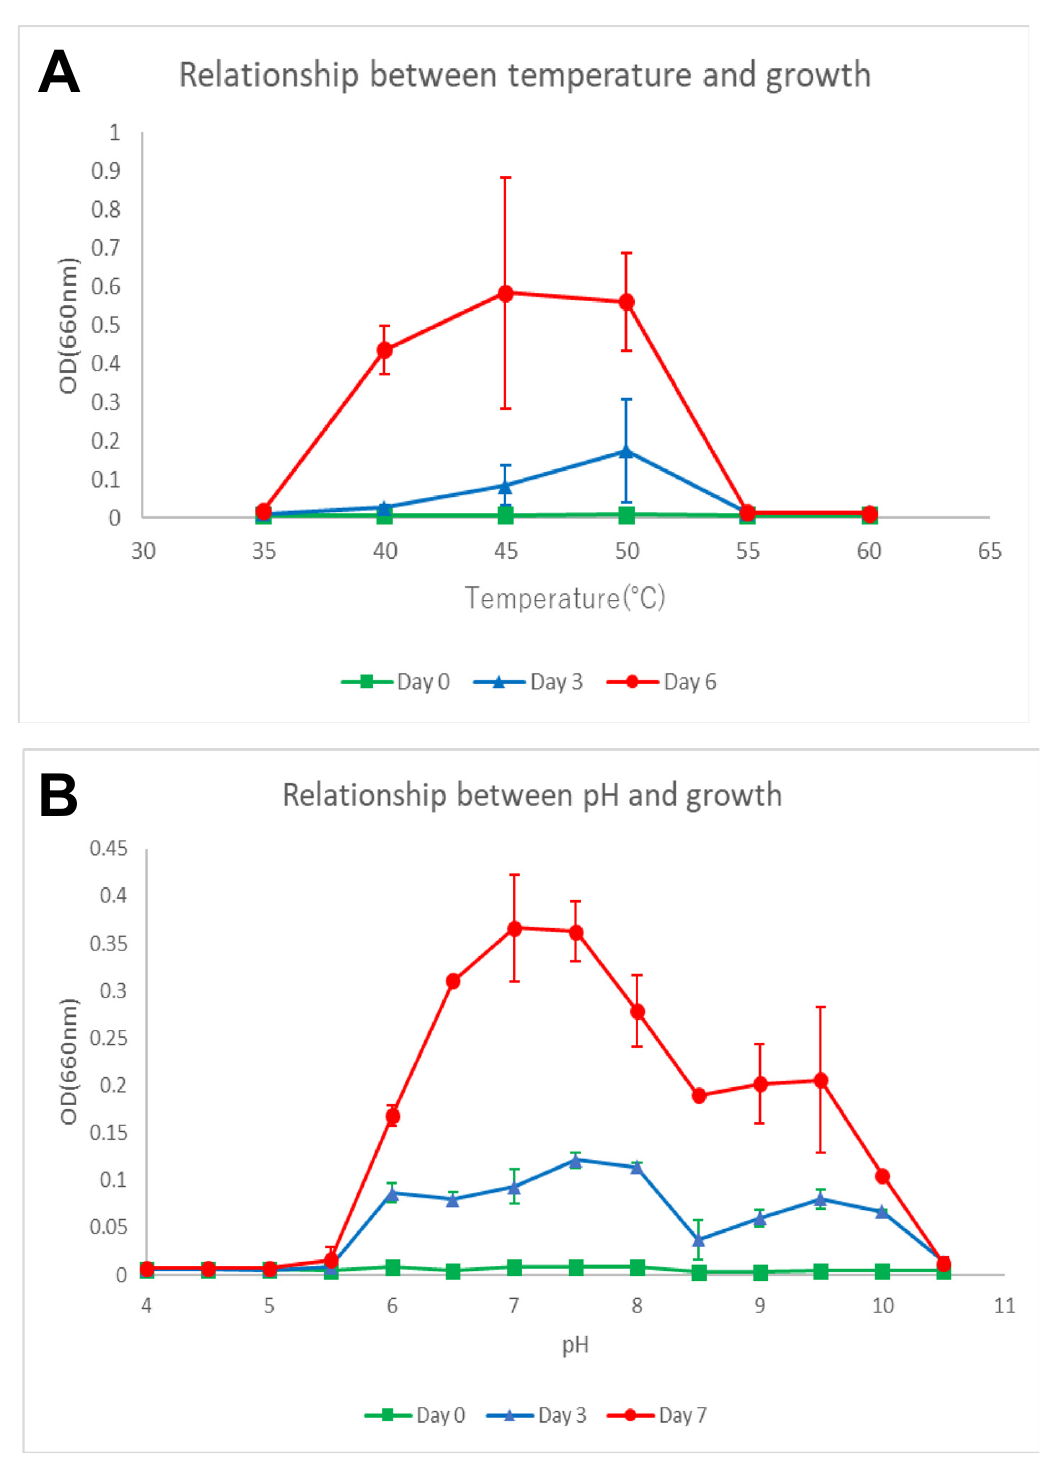
Figure 3. Growth behavior of Elioraea tepida strain MS-P2 T as a function of temperature ( A ) and pH ( B ). Growth of this strain occurred at temperatures greater than 35 °C and lower than 55 °C with an optimum between 45 and 50 °C. Growth occurred over a wide range of pH values above pH 5.5 and below pH 10.5, with an optimum value at pH 7.0 to 7.5. The OD 660 values at time zero (green line), after three days of growth (blue line), and 6 (temperature) or 7 days (pH) of growth (red line) are plotted. The plotted values are the mean and standard deviation values from triplicate cultures.